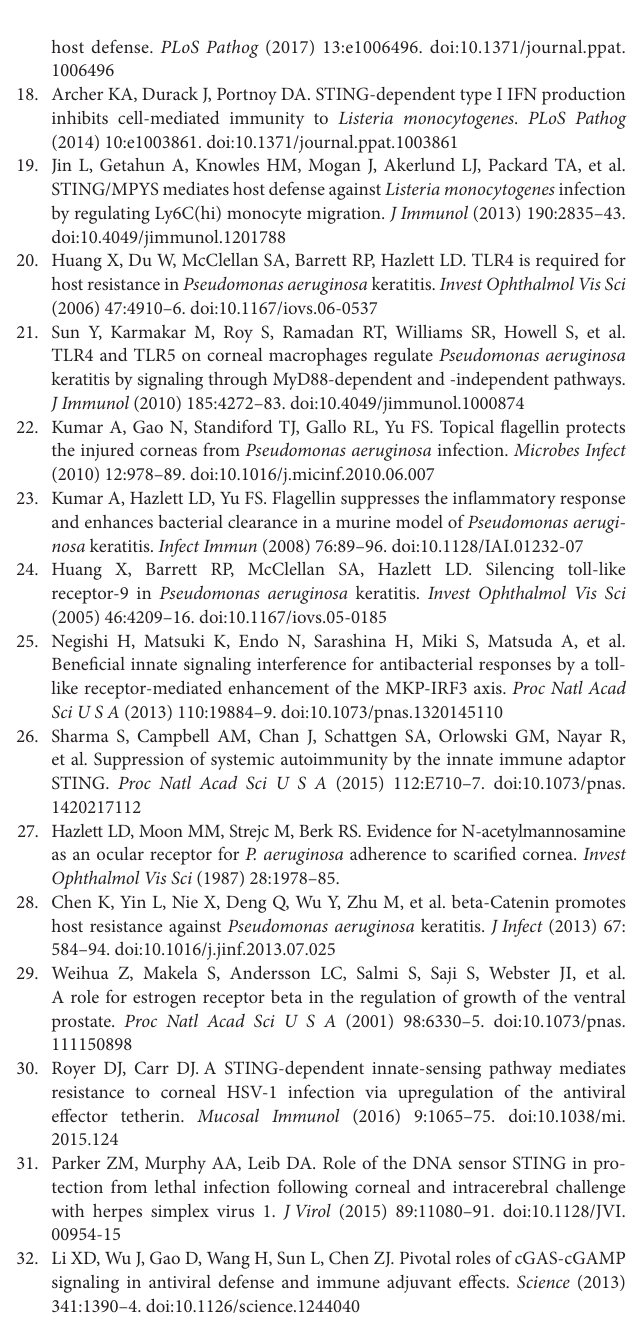
FigUre s1 | Stimulator of interferon genes (STING) suppressed inflammatory cytokine expression and promoted bacterial killing independent of type I IFN. (a,B) mRNA levels of interleukin 1 beta (IL-1 β ) (a) and interleukin 6 (IL-6) (B) were measured by real-time PCR at 6 and 24 h postinfection (p.i.) in RAW264.7 cells after treatment with 2 ′ ,3 ′ -cGAMP (cGAMP) versus control, followed by treatment with IgG versus anti-IFN- β antibody. (c) Bacterial elimination was measured by bacterial plate count assay at 1 and 2 h p.i. in RAW264.7 cells after treatment with cGAMP versus control, followed by treatment with IgG versus anti-IFN- β antibody. (D) mRNA levels of interferon- stimulated gene 15 (ISG15) were measured by real-time PCR in RAW264.7 cells treated with anti-IFN- β antibody versus IgG, to ensure the blocking efficacy of type I IFN signaling. Data are shown as mean ± SEM of three independent experiments. * P < 0.05; ** P < 0.01; and *** P <